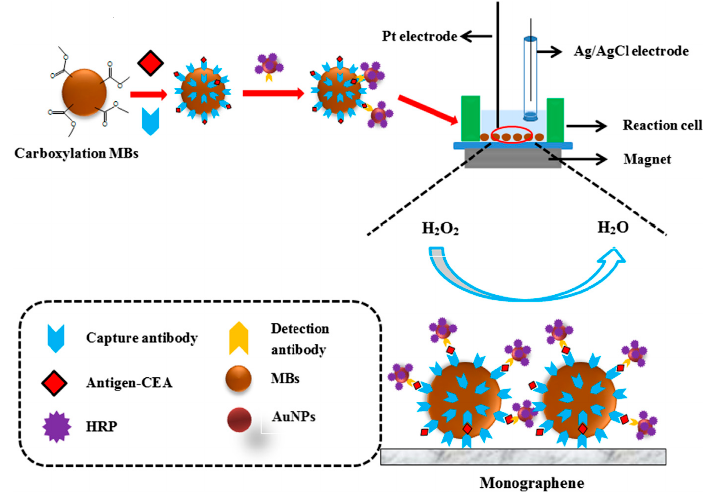
Figure 9. The preparation process of the multi-nanomaterial EC biosensor and the procedure of CEA detection [63]. Copyright 2013. Reproduced with permission from Elsevier B.V.